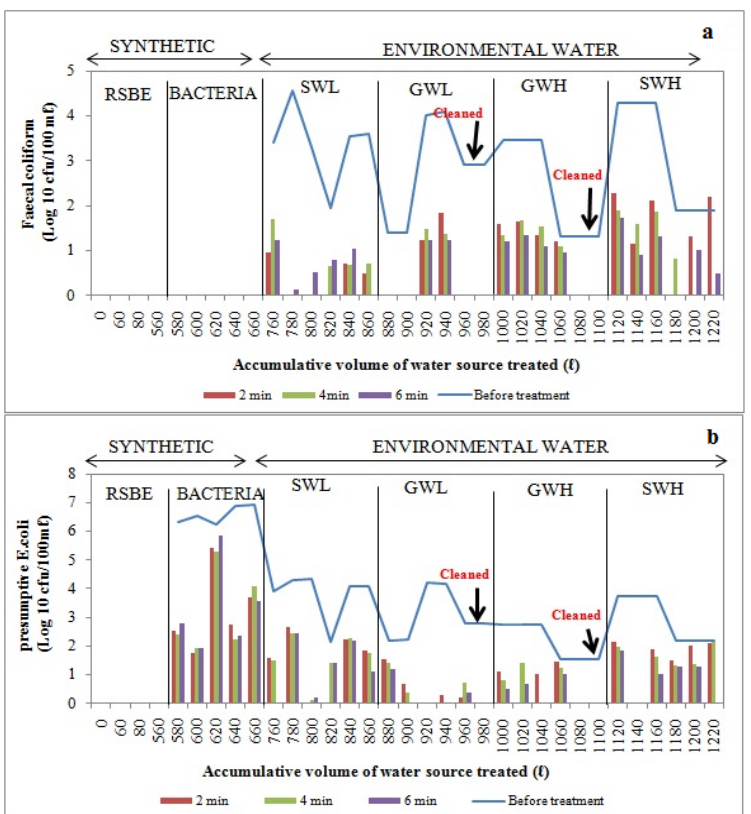
Figure 11. Log faecal coliform ( a ) and E.coli ( b ) concentrations in bucket filter before 10 and after treatment of over 1220 L of source water: synthetic water and environmental water samples (SWL, GWL, GWH and SWH). RSBE is the running of the system before the experiment, using deionised